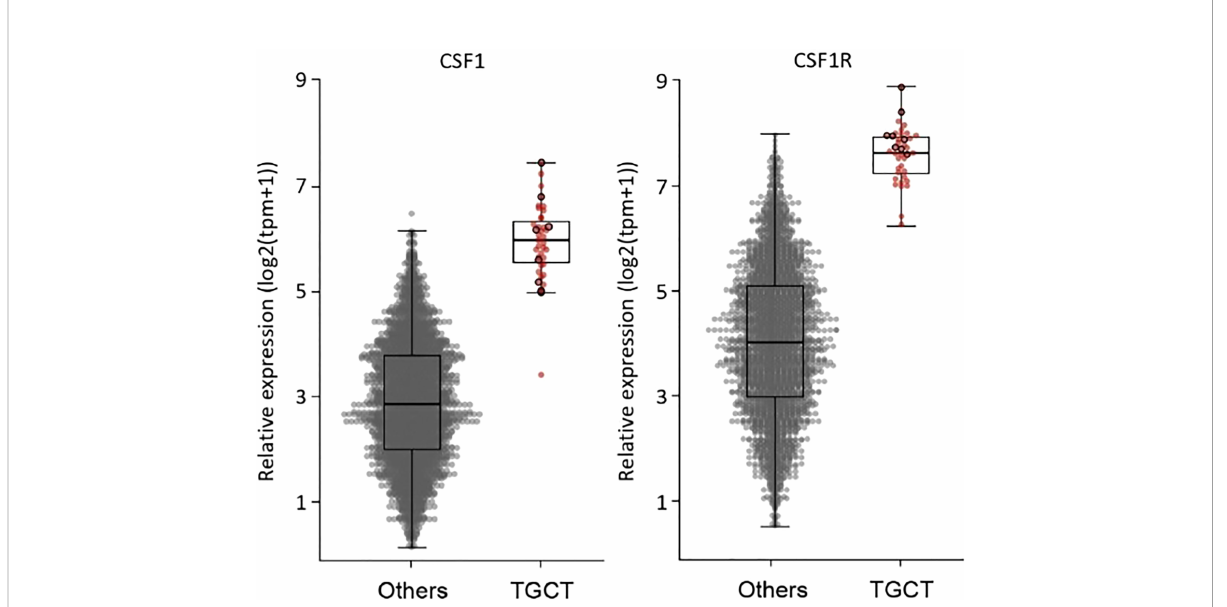
FIGURE 2 Overexpression of CSF1 and CSF1-R in all 39 tumors compared to a control panel of 2642 soild tumors by whole RNA